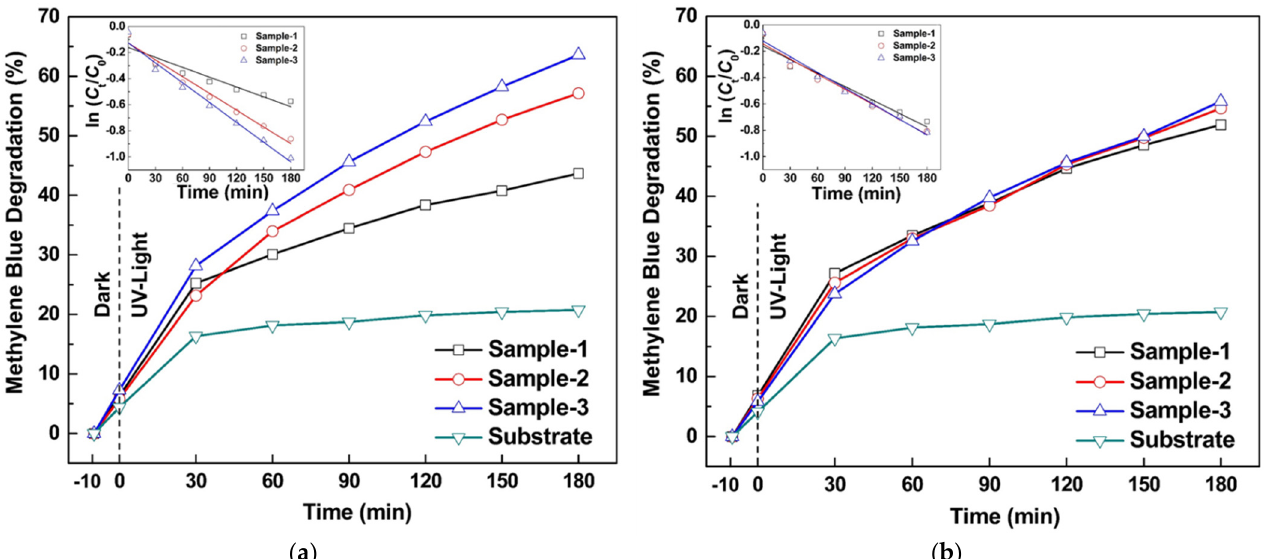
Figure 10. Photocatalytic activity of thin-film samples as the function of the irradiation time in MB solution. Inset: first-order reaction rate of thin-film samples with MB. MB degradation of thin-film samples thermally oxidized at ( a ) 450 ° C and ( b ) 550 ° C.